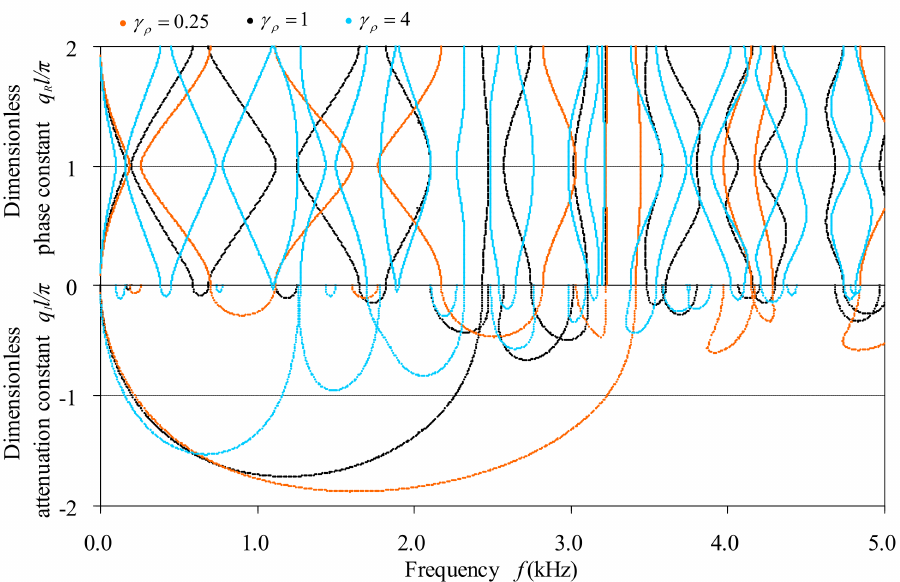
Figure 13. Effect of the mass density of constituent beam on the band structures in the bi-coupled periodic beam with Ternary-I unit cell.